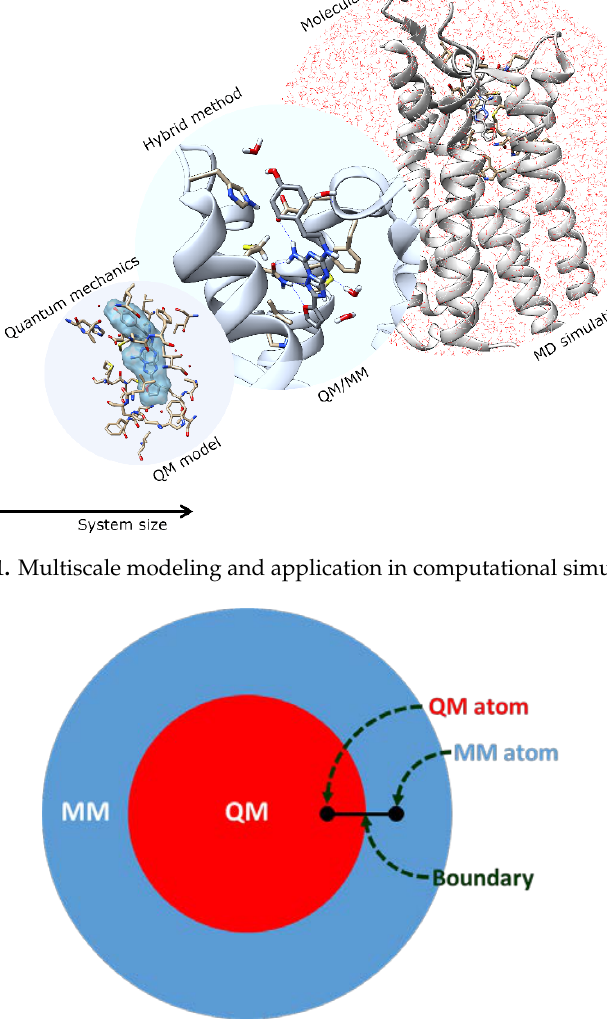
Figure 2. The hybrid quantum mechanics/ molecular mechanics (QM/MM) system partition and atoms at the QM-MM boundary.